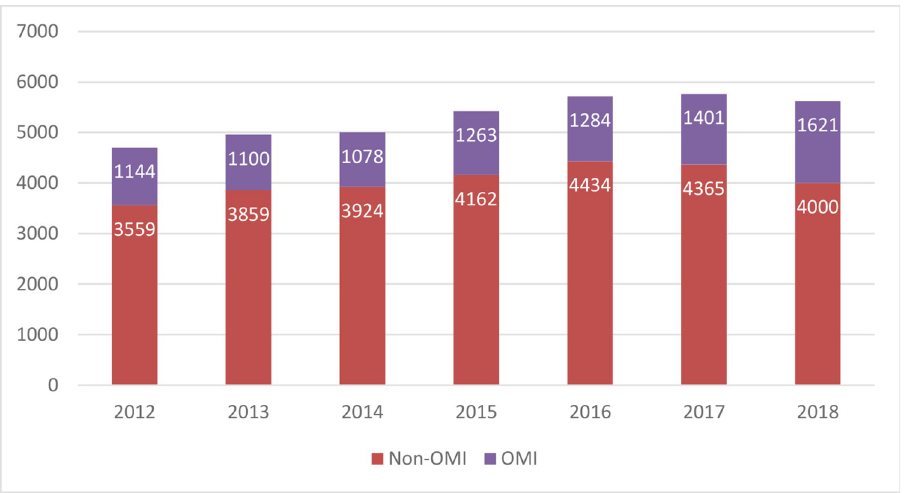
Fig 2. Analysis of motorcycle injury cases by year. OMI; occupational motorcycle